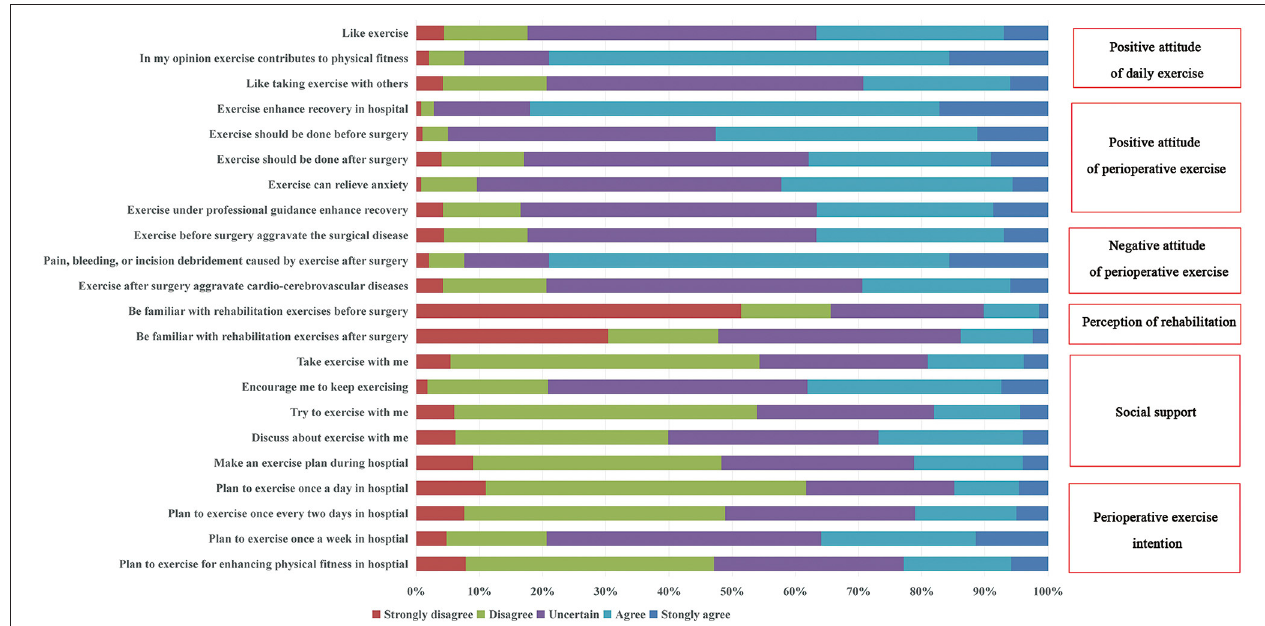
FIGURE 2 | Respondents’ perioperative exercise intention (scores from 4 to 20), positive attitude of daily exercise (scores from 3 to 15), positive attitude of perioperative exercise (scores from 5 to 25), negative attitude of perioperative exercis (scores from 3 to 15), perception of rehabilitation (scores from 2 to 10), and social support (scores from 5 to